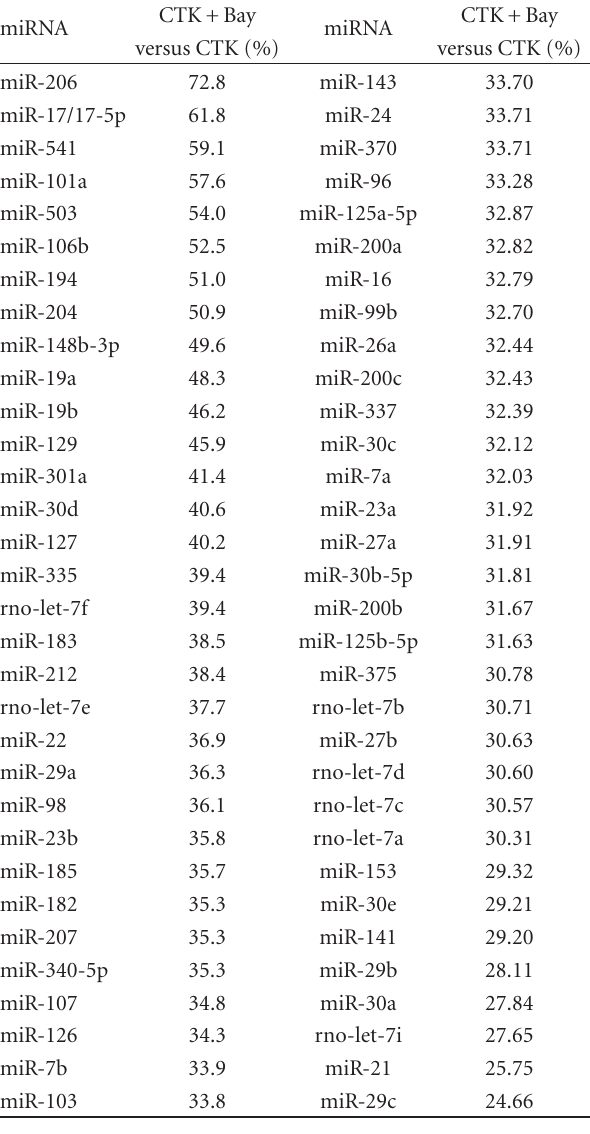
Table 2: miRNAs selected by SAM analysis of global miRNA expression in islets exposed in vitro to cytokines with or without inhibition of the NF- κ B pathway. Values are expressed as percentage of values obtained with NF- κ B inhibitor Bay 11-7082 plus cytokines versus cytokines